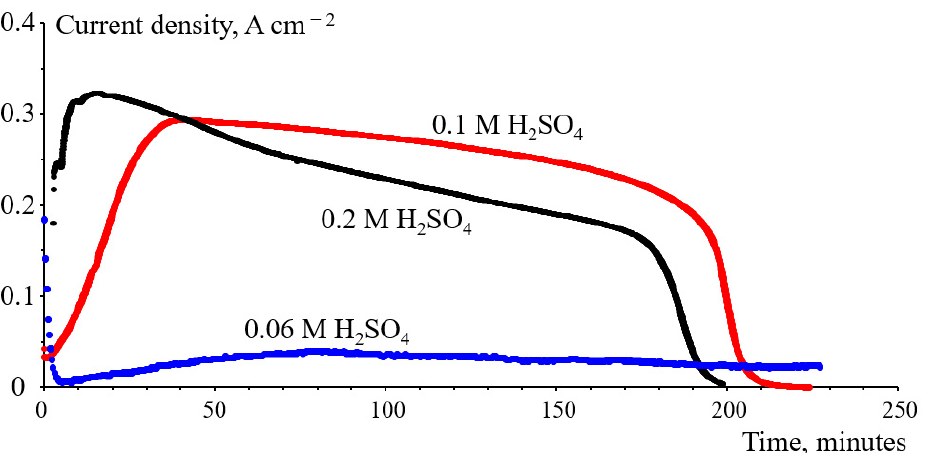
Figure 11. Time variation of current density of a flow cell with a N211 membrane for different concentrations of H 2 SO 4 in the 1 M NaBrO 3 catholyte: 0.2 M, 0.1 M and 0.06 M.